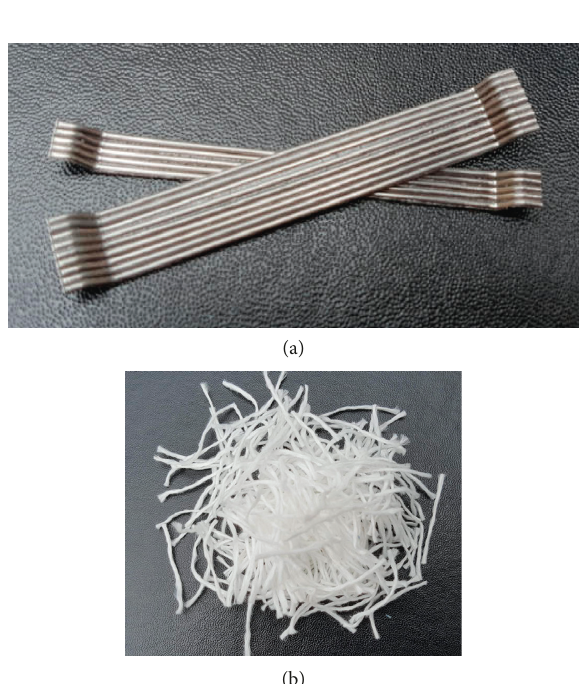
Figure 1: Shape of the fibers. (a) Steel fiber (SF). (b) Polyaramid fiber